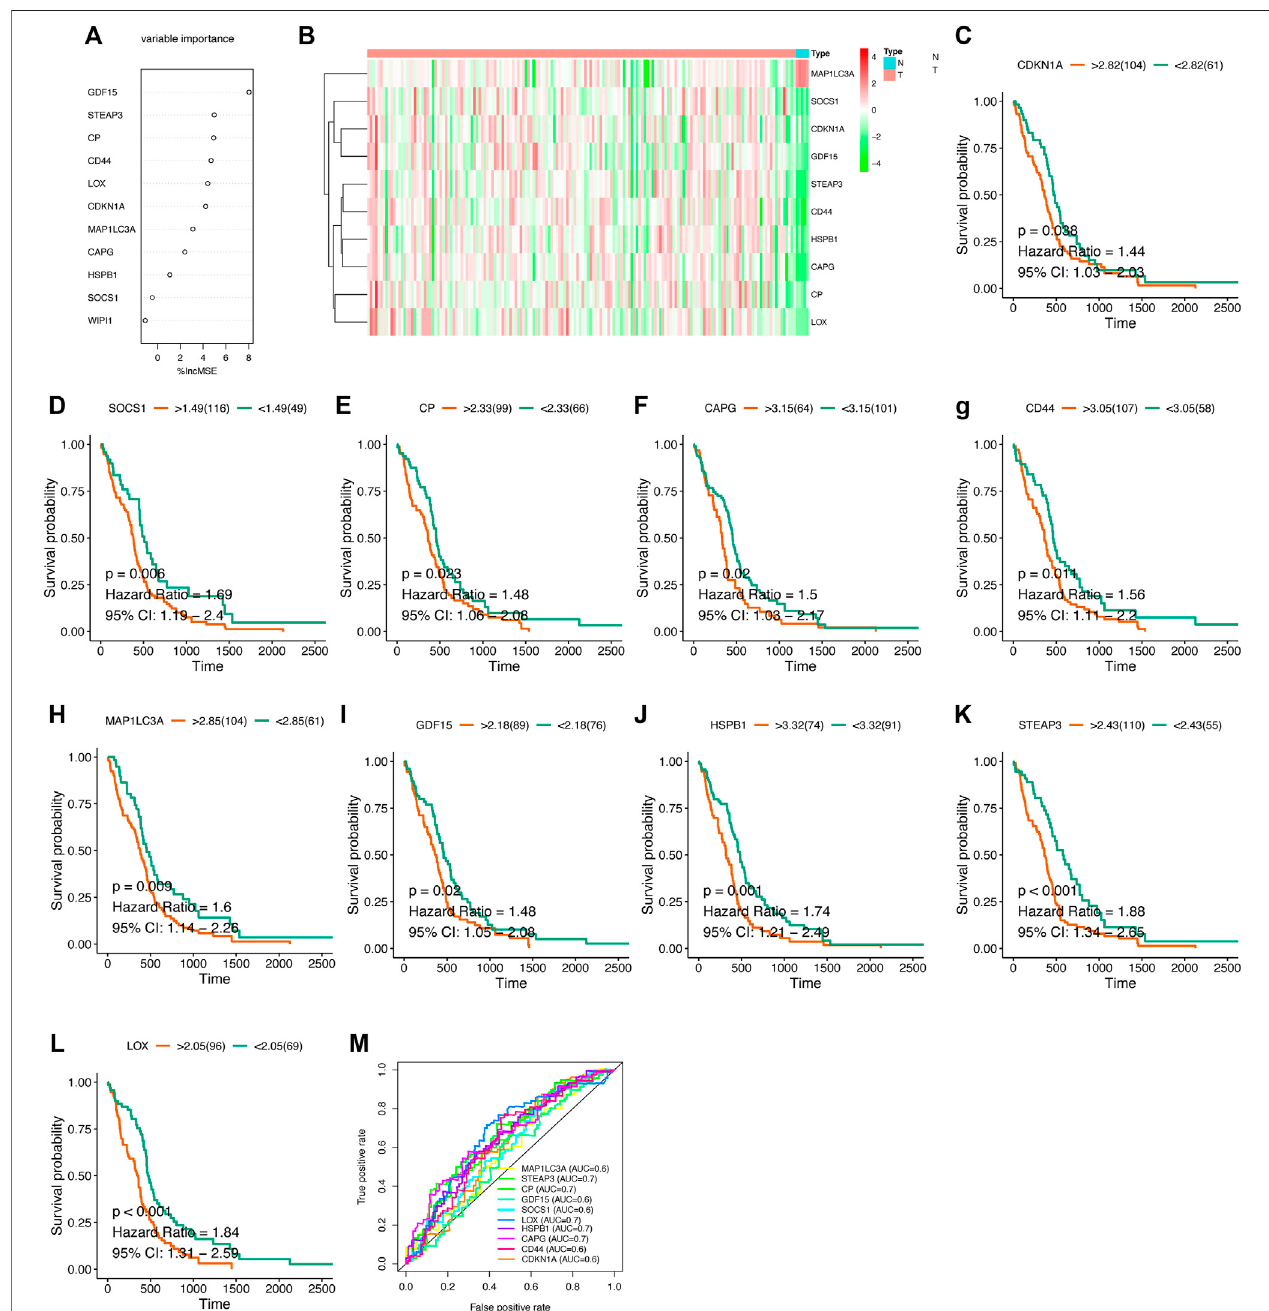
FIGURE 4 | Survival analysis of key genes (A) Random Forest screening for ten key genes (B) Heat map of expression of key genes in different groups (C – M) Kaplan-Meier survival curve and ROC curve.